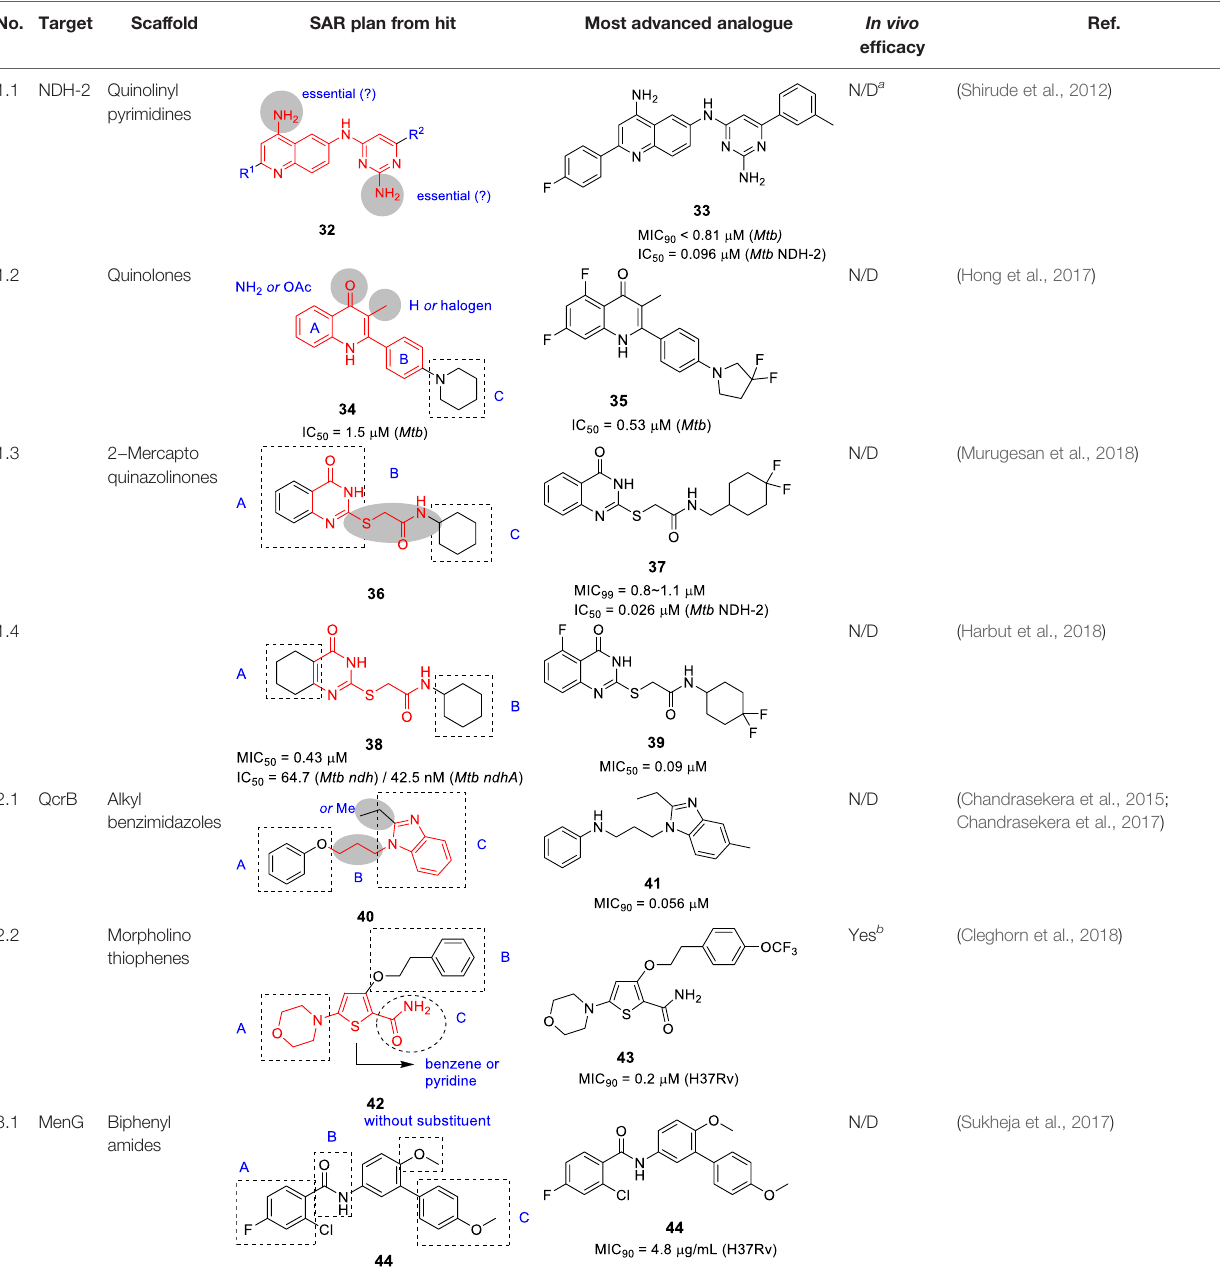
TABLE 3 | Antitubercular agents inhibition the mycobacterial respiratory system. No.